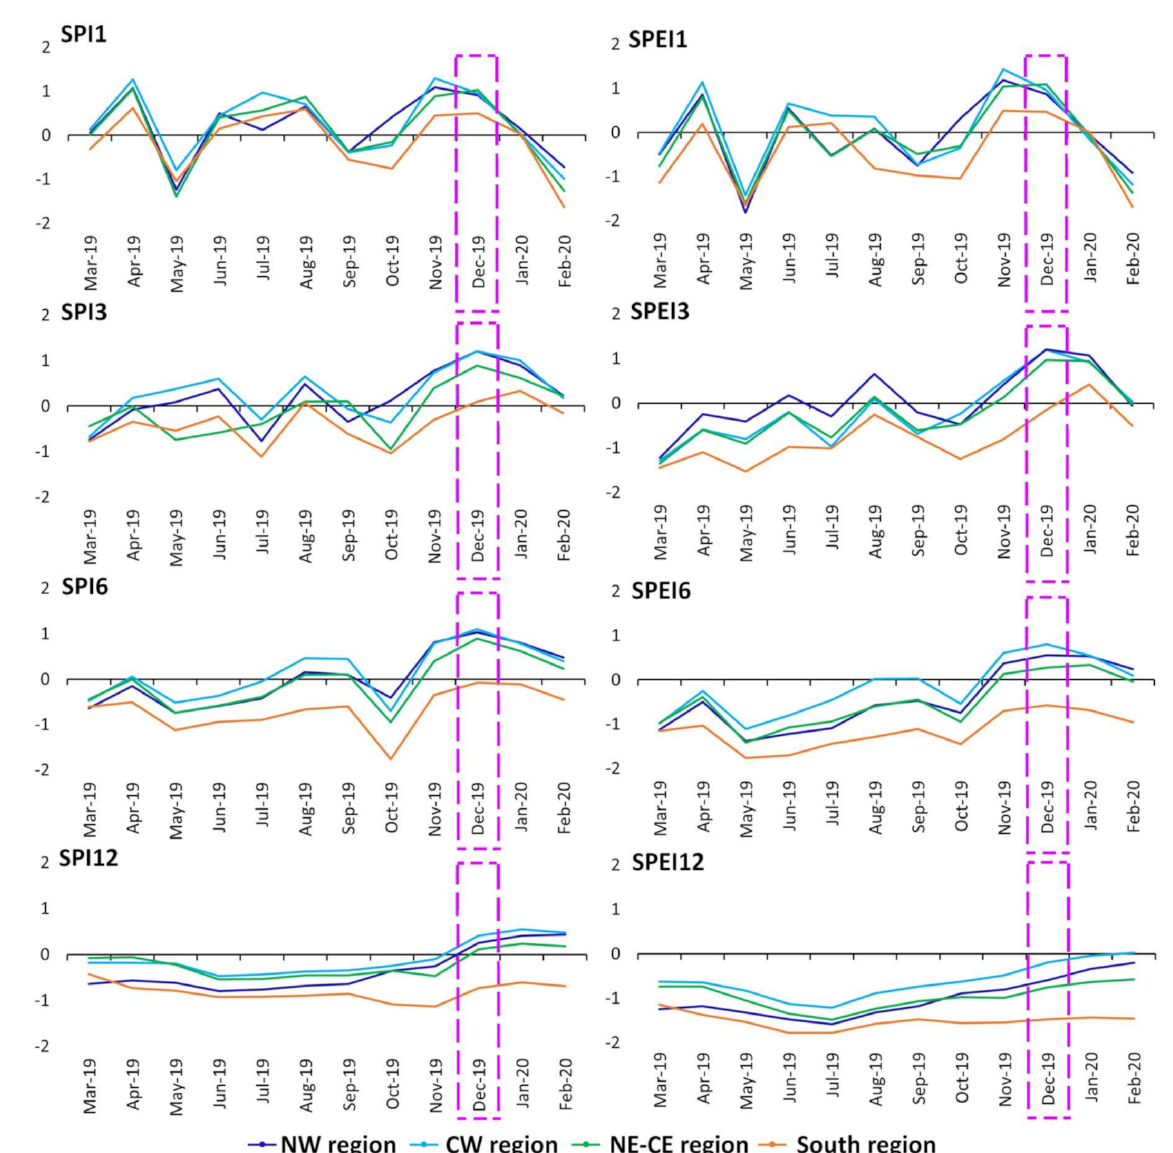
Figure 7. Temporal evolution of the SPI (left) and the SPEI (right) at temporal scales of 1, 3, 6, and 12 months for mainland Portugal for the period: March 2019–February 2020. Box of discontinued magenta lines indicates the month of impact (December) by Daniel, Elsa, and Fabian in mainland